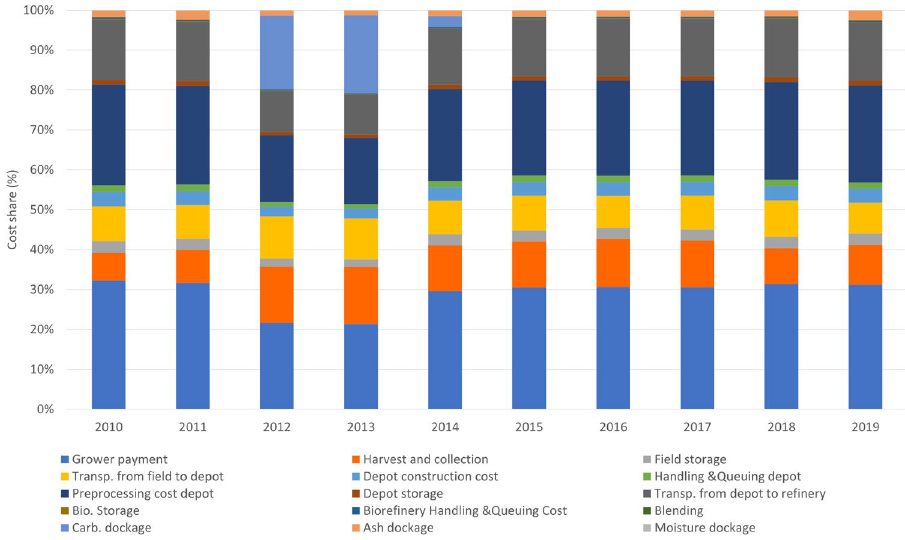
Figure 7. Cost share of each supply chain component in the total feedstock cost in Scenario 11 (2010–2019 based) (supply chain is optimized based on 10-year weather